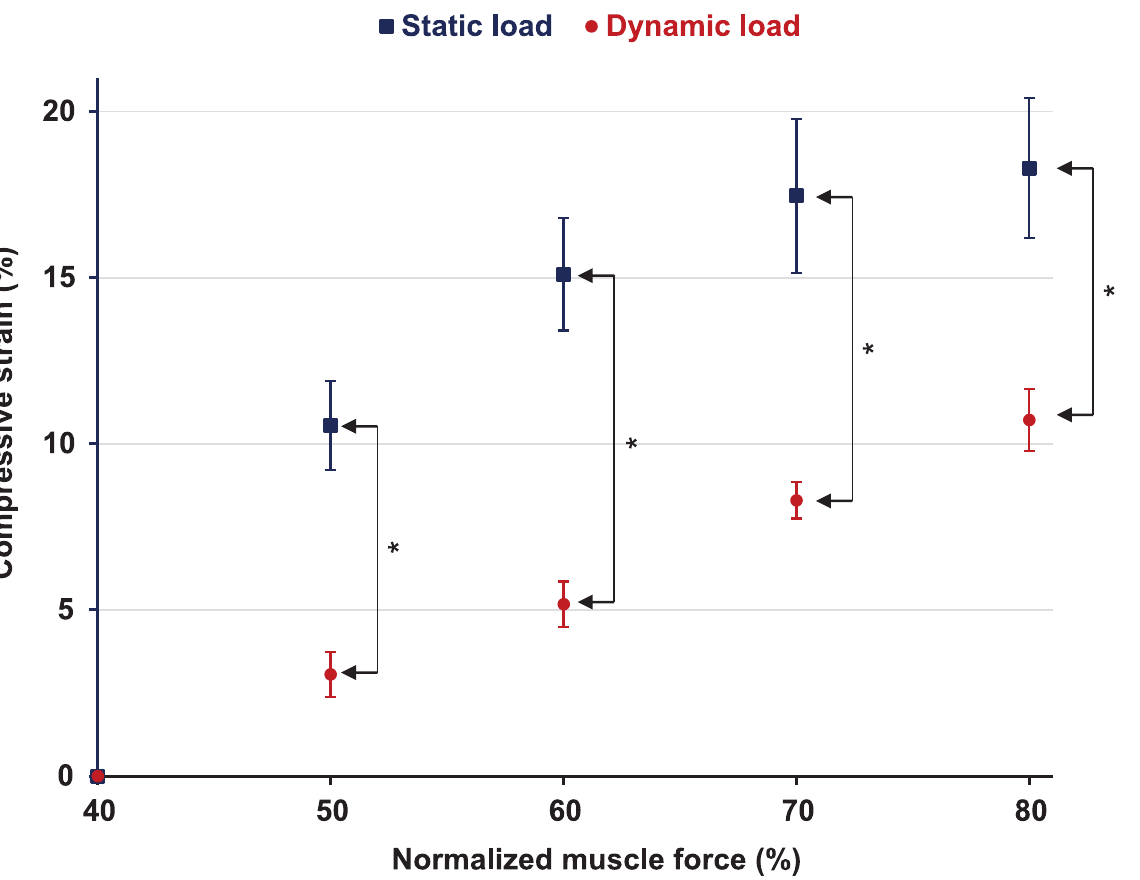
Fig 5. Peak compressive strains as a function of normalised muscle force for static and dynamic loading. For static loading, articular cartilage surfaces do not touch below approximately 40% of maximal muscle force, then cartilage strain increased between about 40 – 70% of the maximal force, and remained almost constant from 70 – 80% of maximal force (n = 7). For dynamic loading, articular surfaces did not touch below ~40% of the maximal isometric muscle force. Beyond ~40% force porduction, cartilage strains increased almost lineary between 50 – 80% of the maximal force (n = 6). Vertical bars on the side show significant differences between